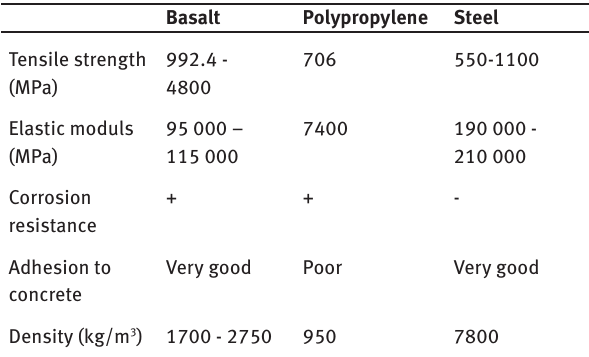
Table 2: Mechanical property of fibers (Sim et al. 2005, Kizilkanat et al. 2015, Karwowska et al. 2011, Deng et al. 2021a).